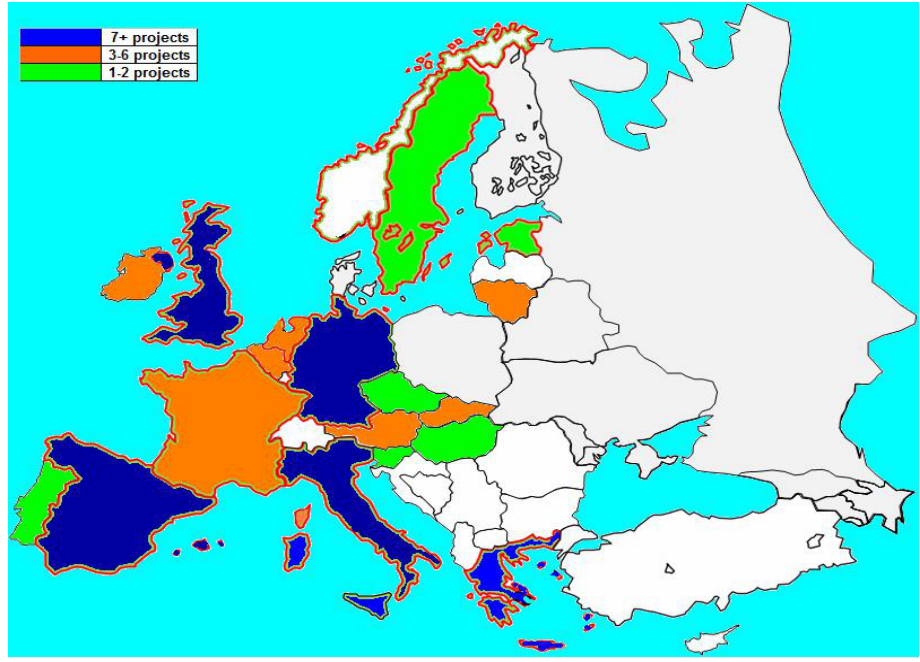
Figure 1: country representation map (MOMENTUM White Paper, June 2009)